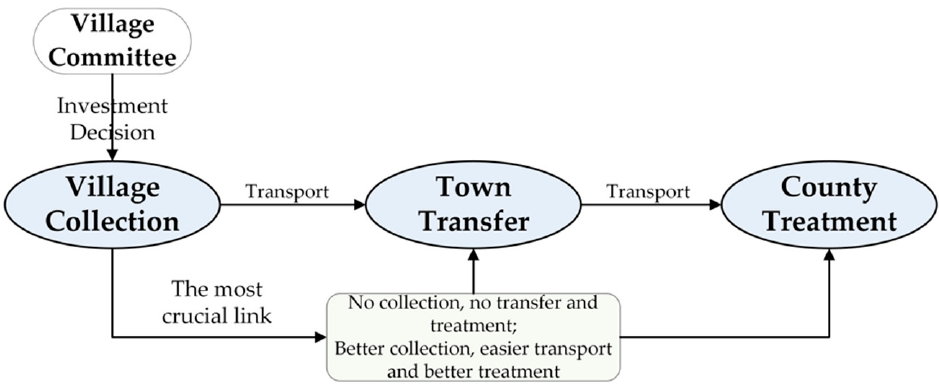
Figure 2. The management framework of RRSW in China. Table 1. The definition and data description of the variables involving in the model 1 .